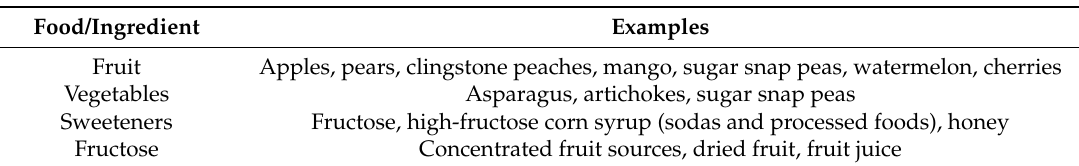
Table 1. Foods containing high amounts of